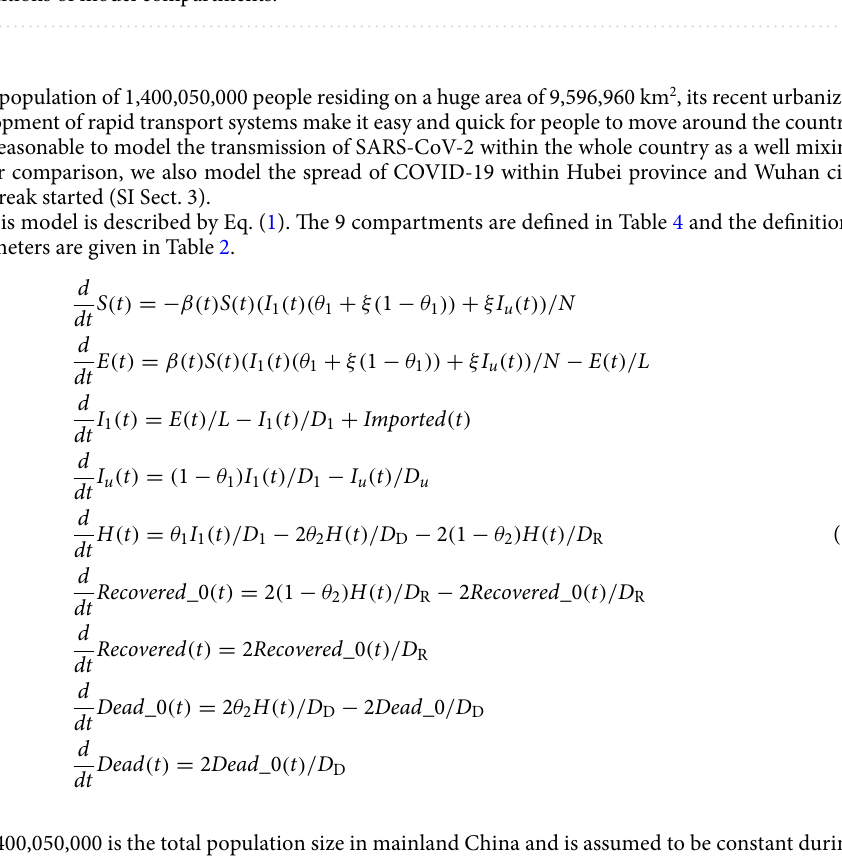
Table 4. Definitions of model